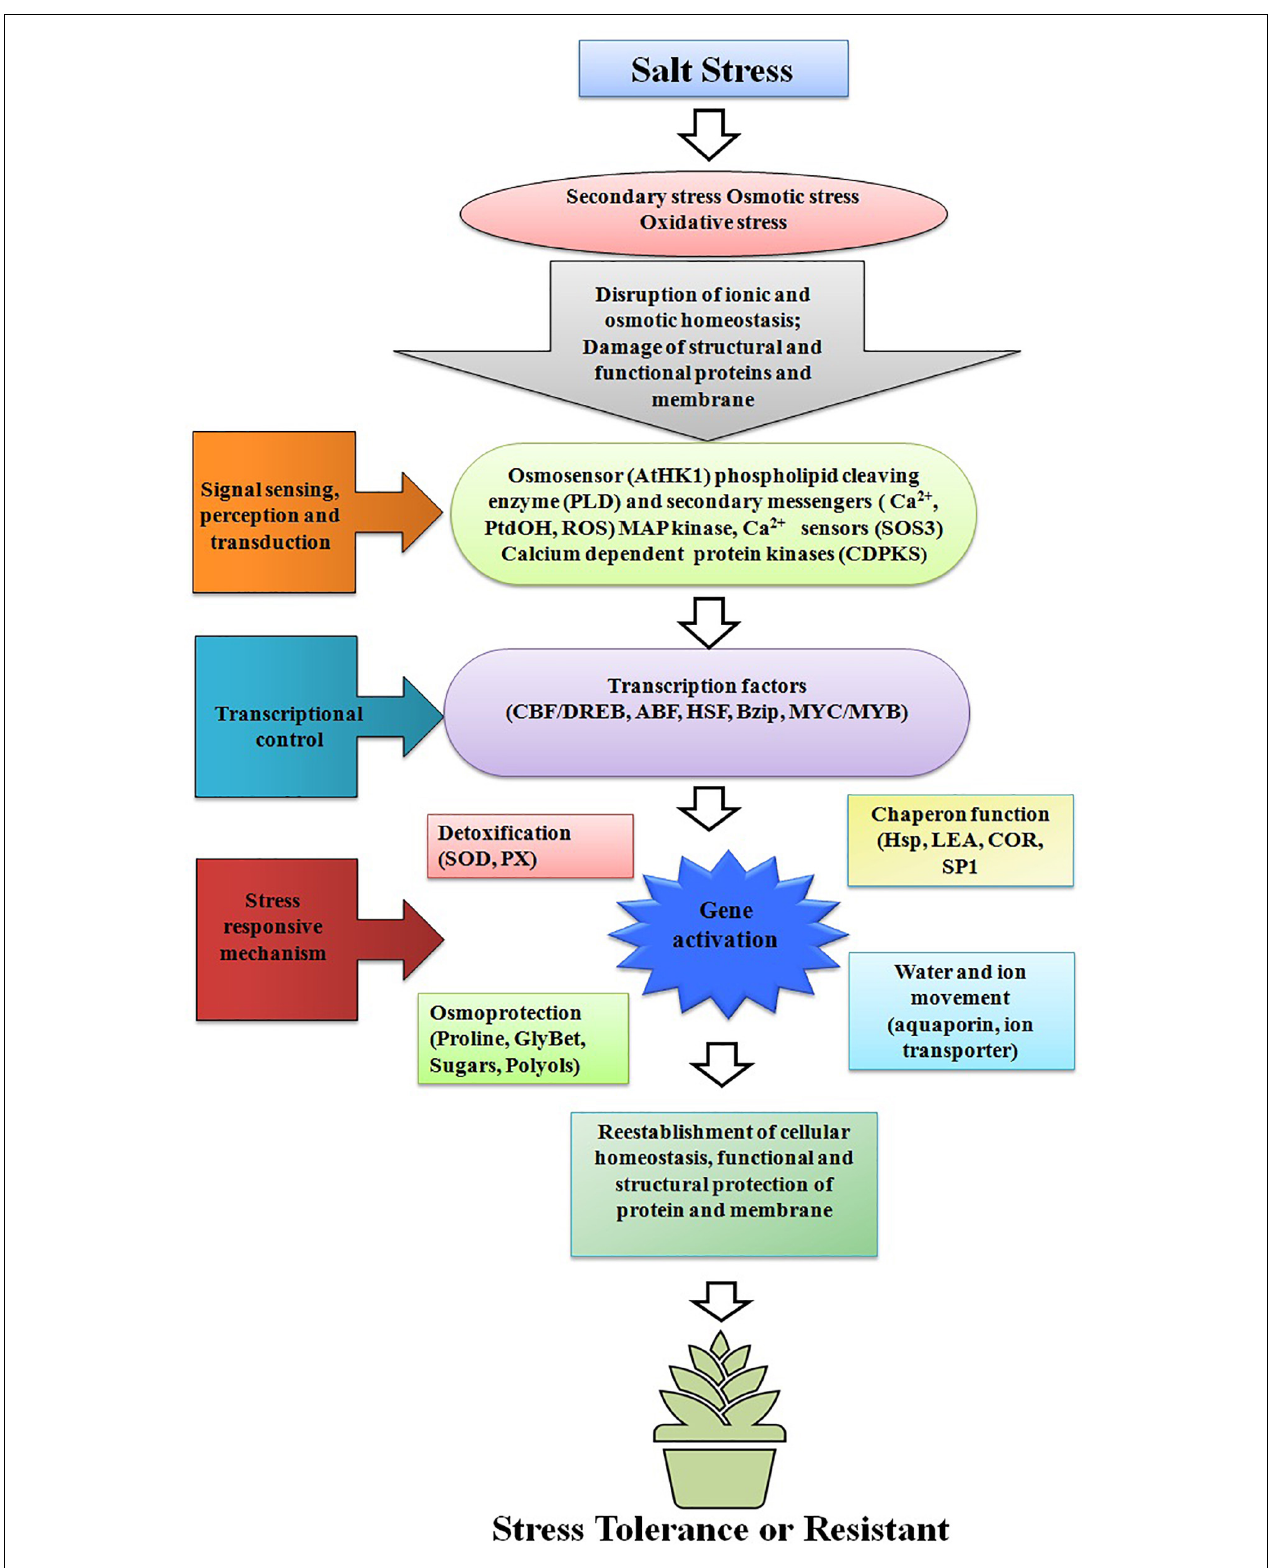
FIGURE 1 | Mechanisms of transgene action in transgenic plants; downstream signaling process and transcription controls that stimulates stress-responsive mechanisms to reestablish cellular homeostasis and damage repair.